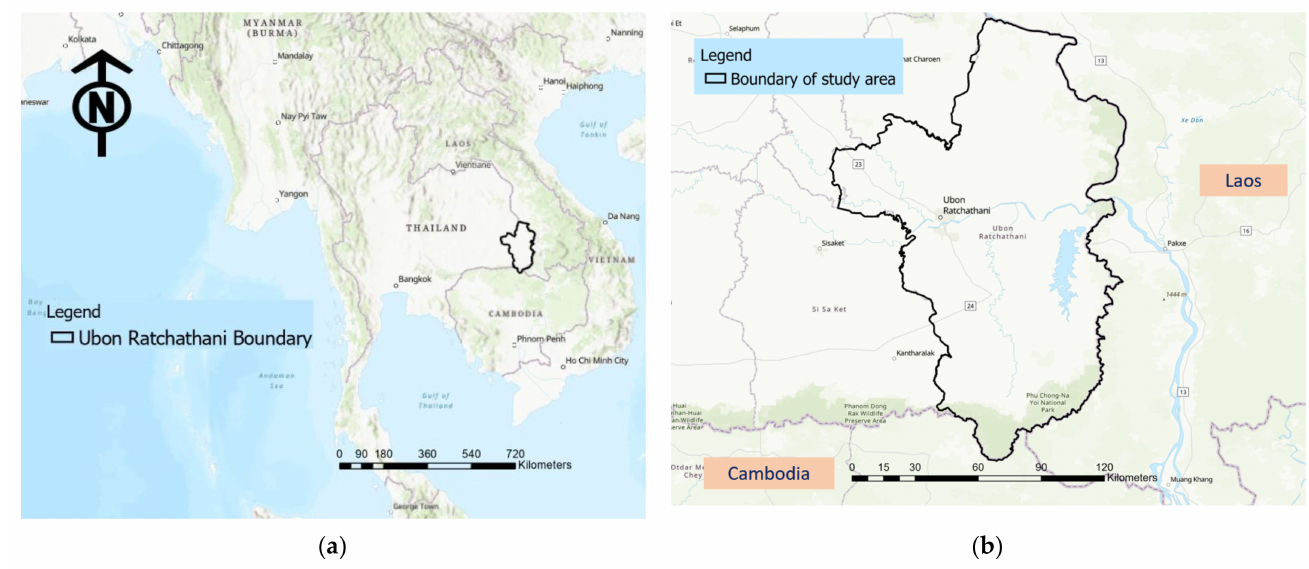
Figure 3. Location of study area: ( a ) Ubon Ratchathani in Thailand; ( b ) study area surrounded by the neighboring countries of Laos and